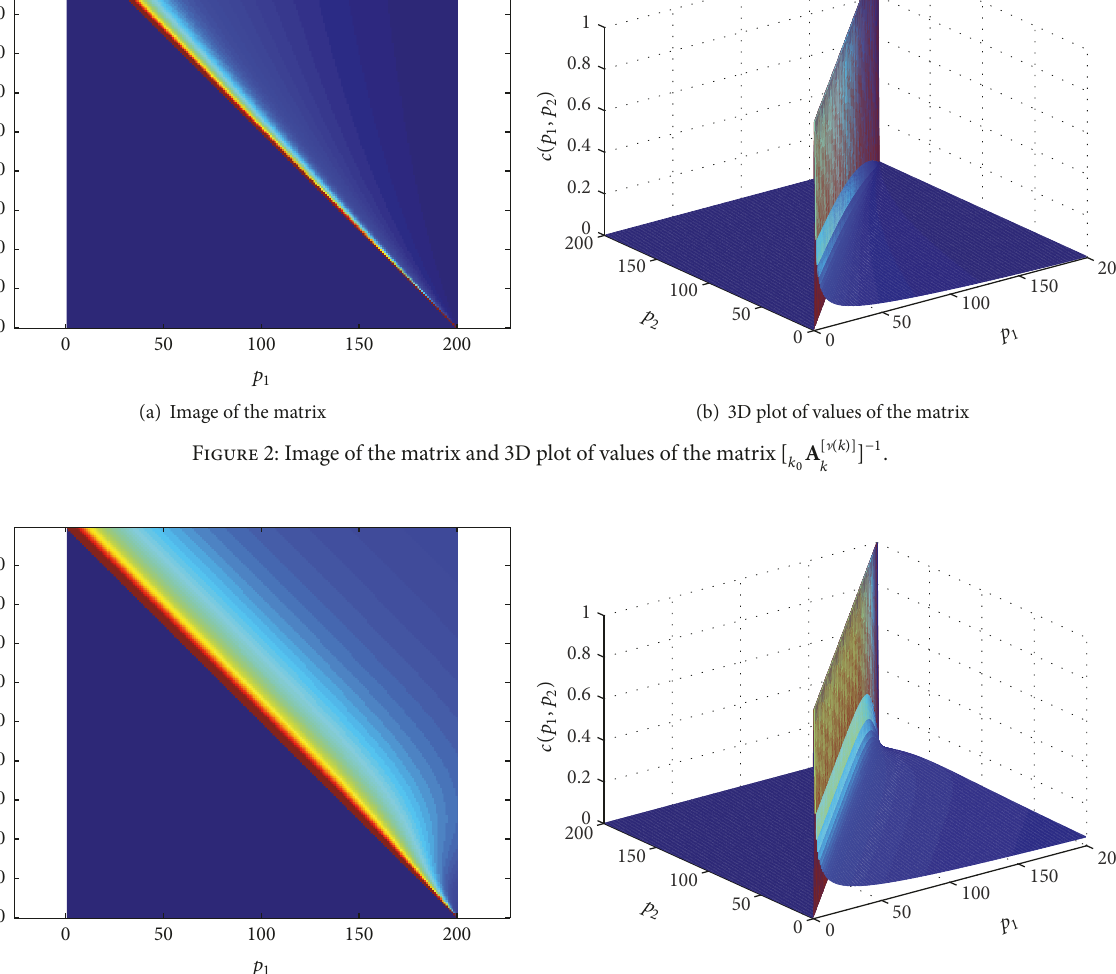
Figure 3: Image of the matrix and 3D plot of values of the matrix 𝑘